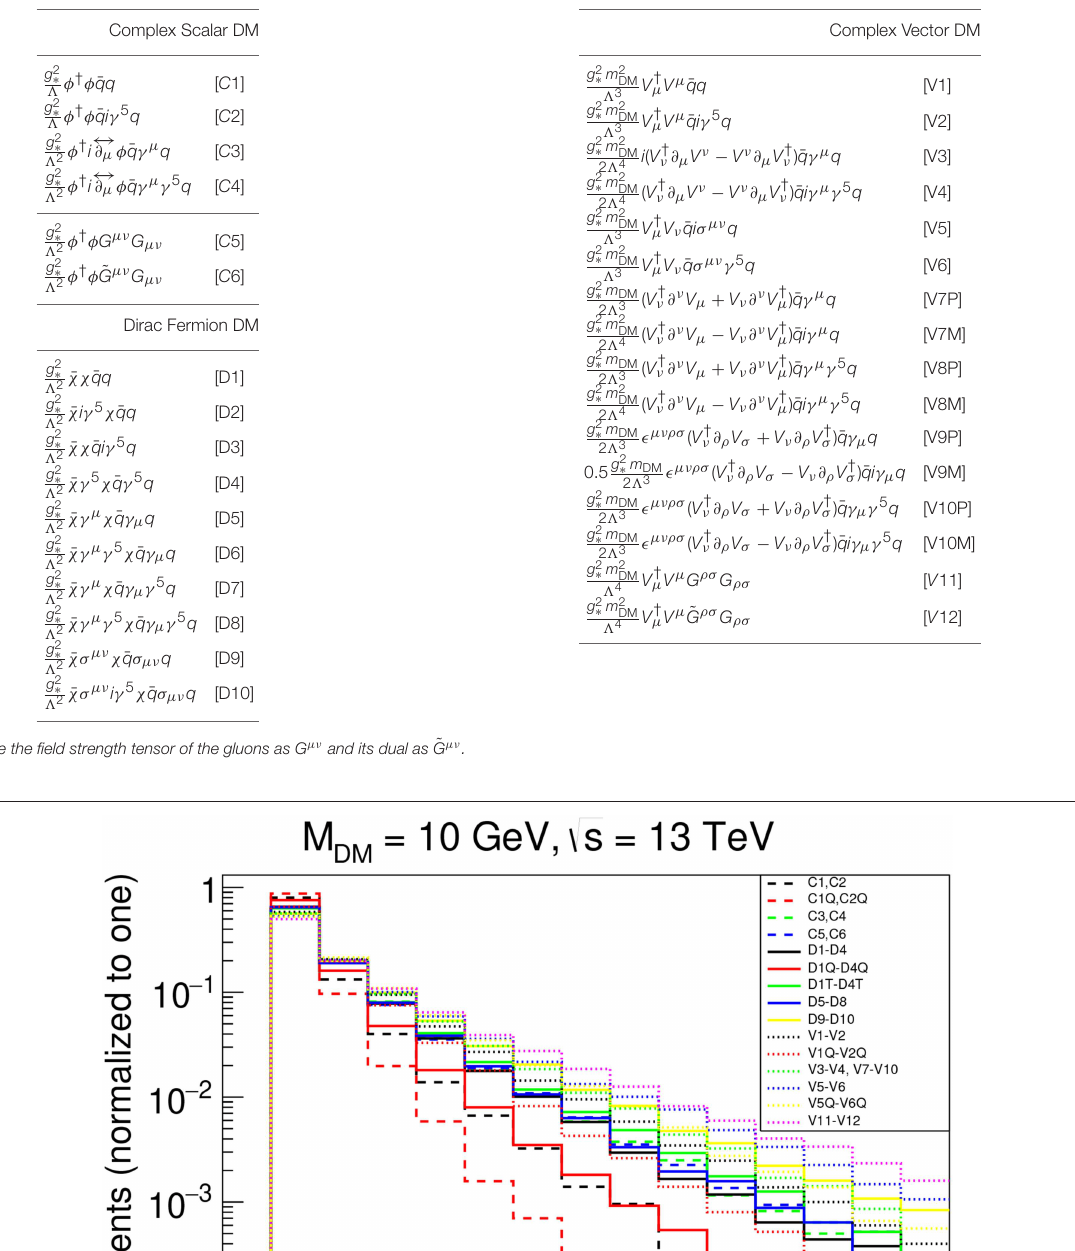
FIGURE 1 | E miss T parton level distributions for a representative subset of the EFT operators from Table 1 for 13 TeV LHC energy and M DM